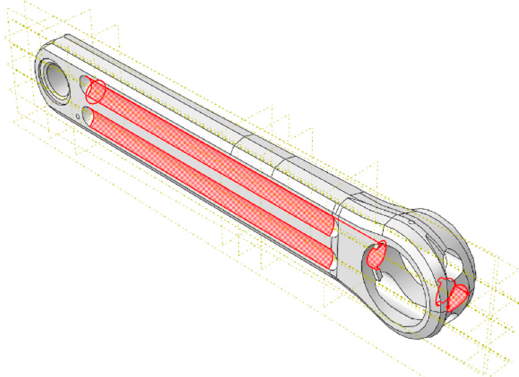
Figure 20. New crank arm optimized.